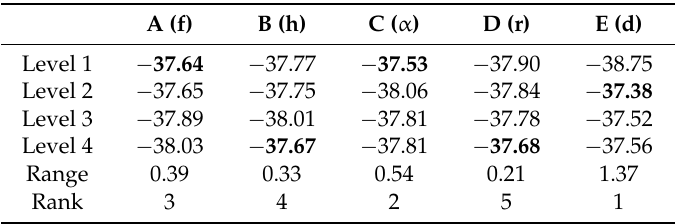
Table 5. Forging load response of the third upper punch based on S / N L ratios.